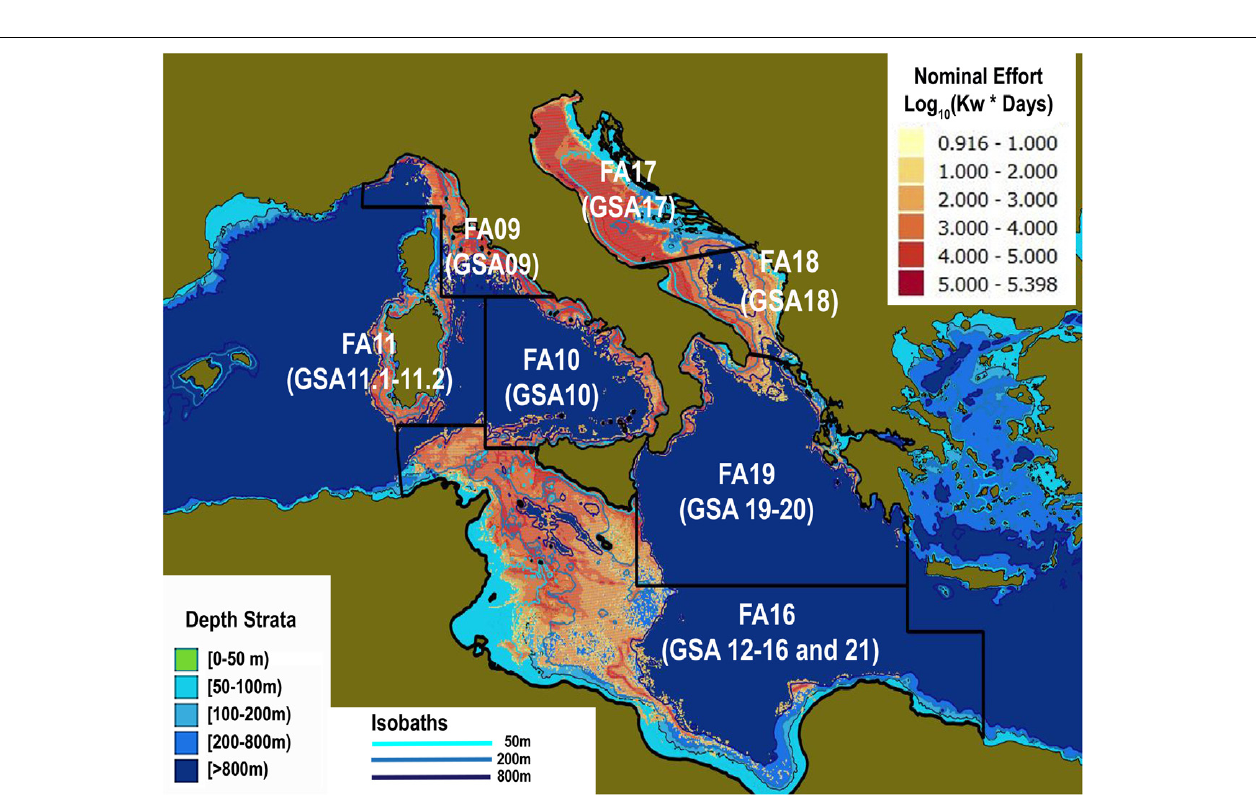
FIGURE 3 | Mean annual distribution of the trawling nominal effort by the OTB 15 fleet during the period 2009–2016. The grid used to assess the Nominal Effort is the standard 3 × 3 km square used within the EU DCF. The logarithmic scale was used to better represent the pattern, while the main depth strata are reported.